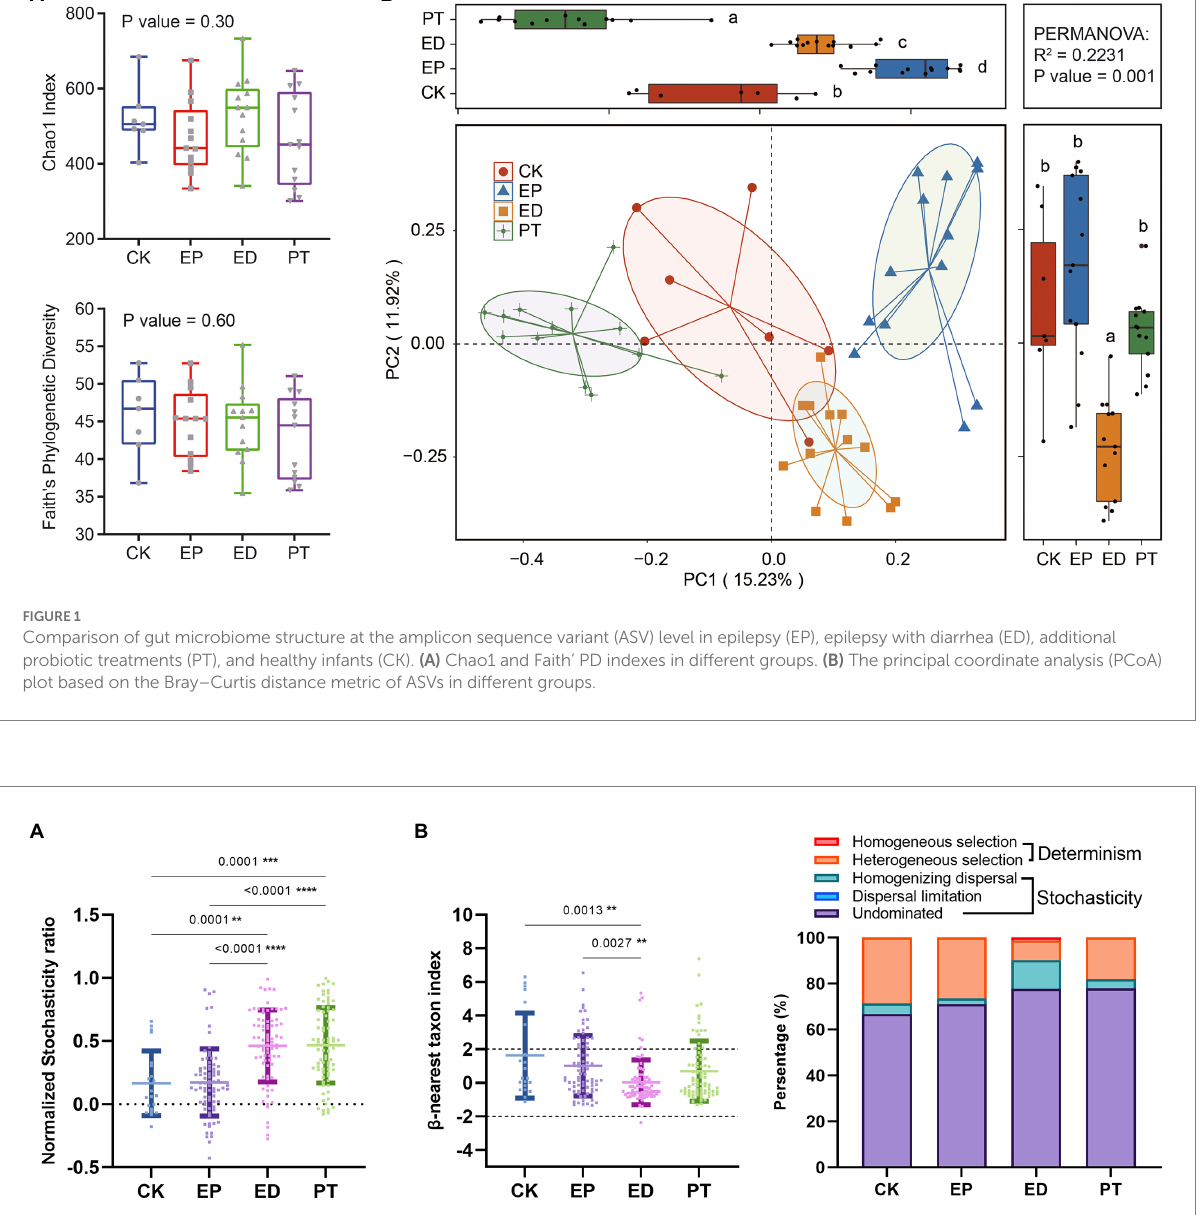
FIGURE 2 Comparisons to determine assembly mechanisms of intestinal microbiota among individuals within different groups (EP, ED, PT, and CK). (A) Normalized stochasticity ratio (NST) in different groups. (B) β -Nearest taxon index ( β NTI) in different groups and dynamics of the relative importance of different community assembly processes. Asterisks indicated comparisons with an adjusted p -value <0.05, based on Tukey’s multiple comparisons test. CK, healthy controls, EP, epilepsy; ED, epilepsy with diarrhea; PT, probiotic